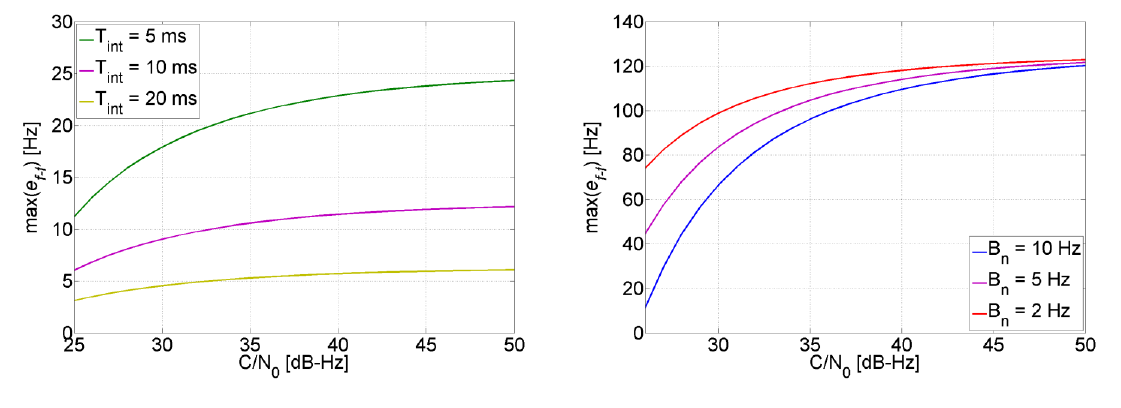
Figure 4. PLL tolerable assistance frequency error when T